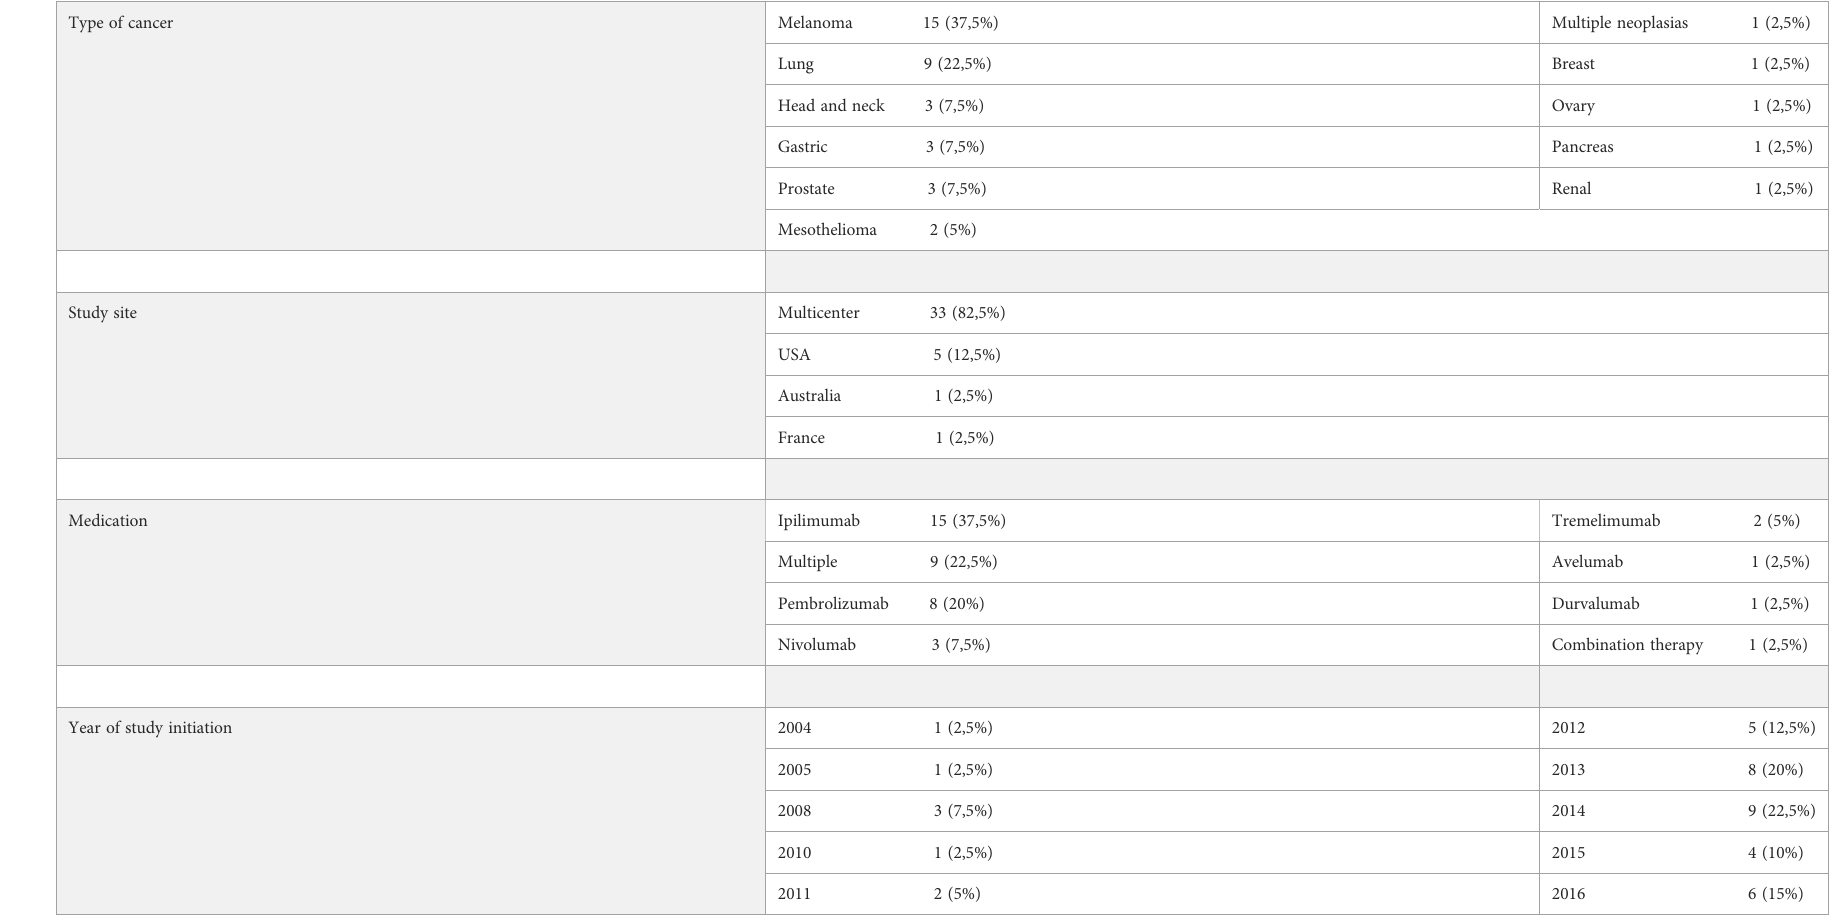
TABLE 3 Distribution of randomized clinical trials according to the type of cancer studied, location of the study, medication used and year of study